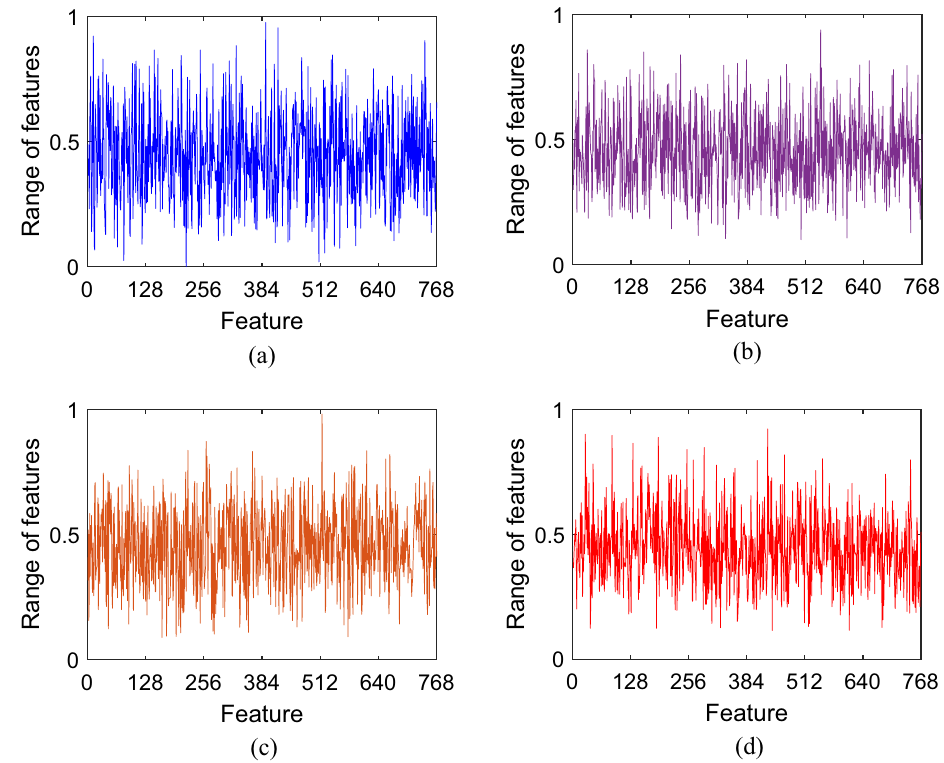
Figure 2. Generated feature vector samples for the different classes of the UNBC-McMaster dataset: ( a ) PSPI = 0, ( b ) PSPI = 1, ( c ) 2 ≤ PSPI ≤ 3, ( d ) PSPI >